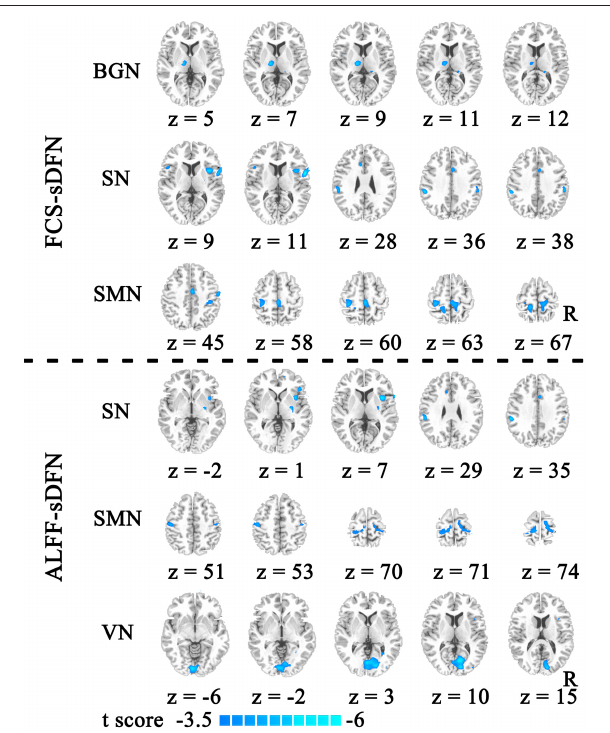
( Figure 6A : SC, Figure 6B : connectivity). The SC-ICC value of FCS-sDFN ranges from 0.45 to 0.76 (mean value: 0.66, standard deviation: 0.10). The connectivity–ICC value of FCS- sDFN ranges from 0.47 to 0.88 (mean value: 0.77, standard deviation: 0.08). The ALFF-sDFN ICC values of SC and connectivity between sDFN are higher than the ICC score of FCS- sDFN: SC-ICC: 0.75–0.87, mean ± standard deviation: 0.79 ± 0.04; connectivity–ICC: 0.93–0.96, mean ± standard deviation: 0.95 ± 0.007.